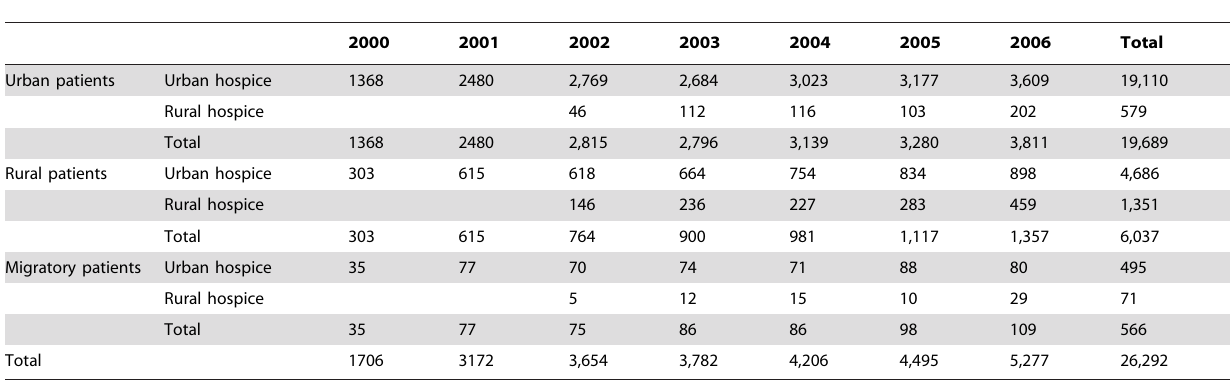
Table 3. The first-time admissions to hospices from 2000–2006, stratified by patient’s residence and hospice’s